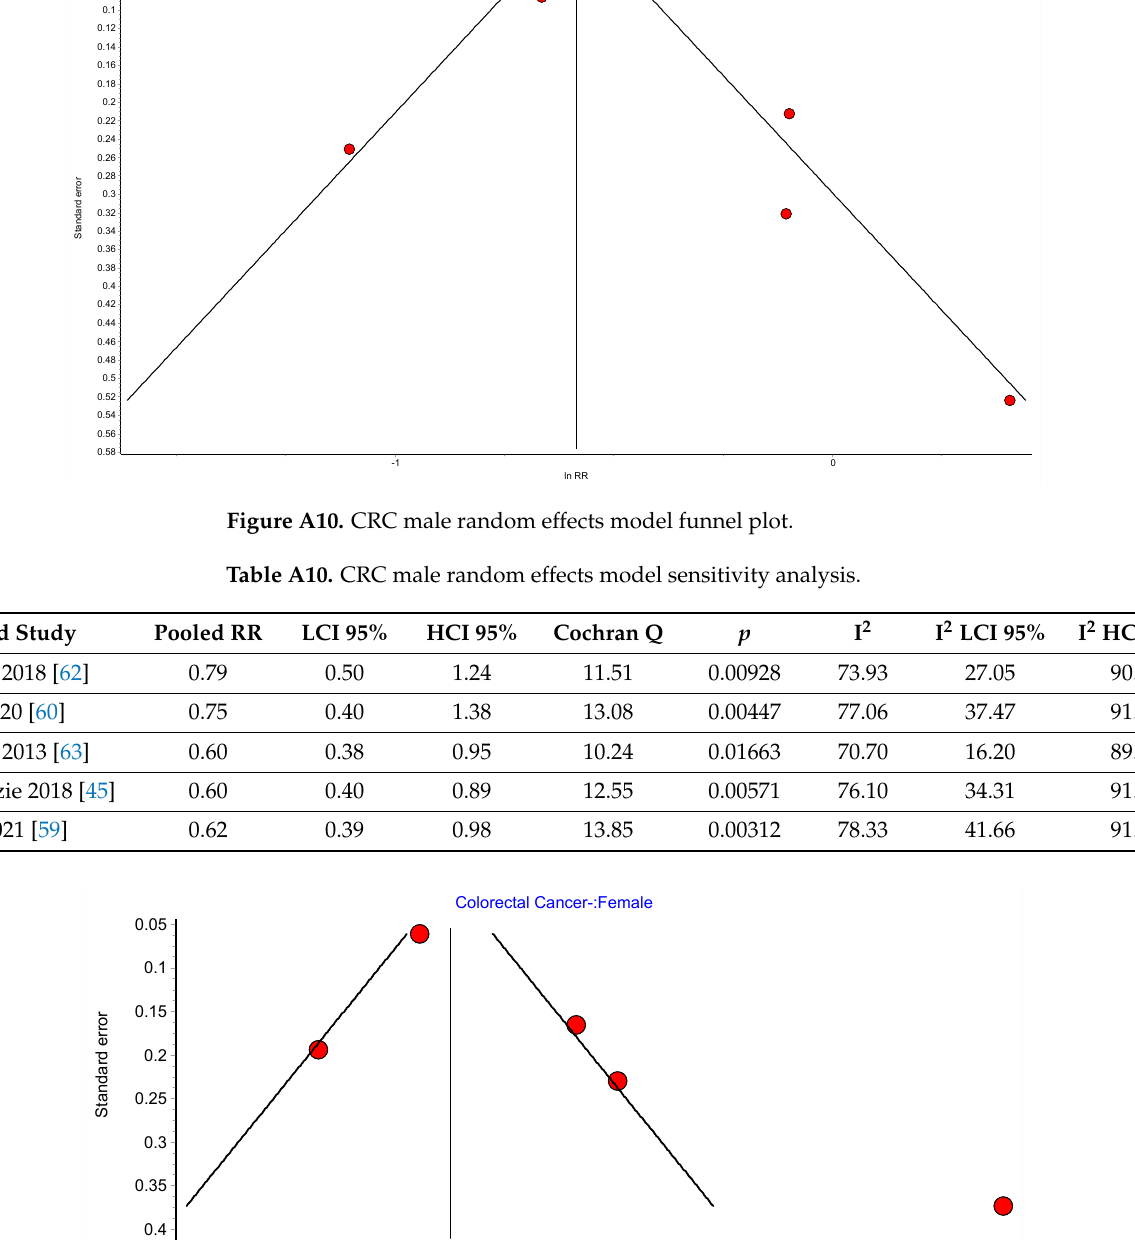
0-1 ln RR Figure A11. CRC female random effects model funnel plot. Figure A11. CRC female random e ff ects model funnel plot. Table A11. CRC female random effects model sensitivity Table A11. CRC female random e ff ects model sensitivity analysis.